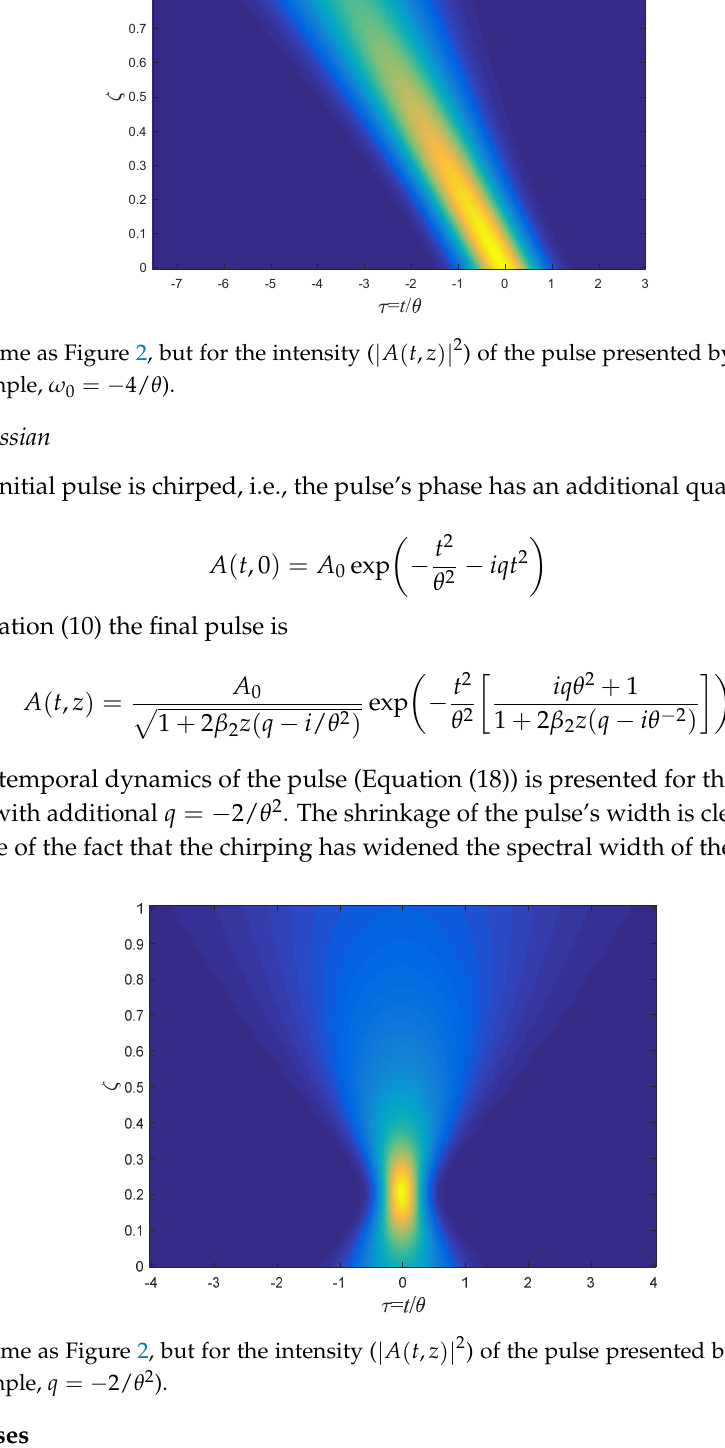
 z ), while the solid 2  z ). In this example, the carrier frequency is 2